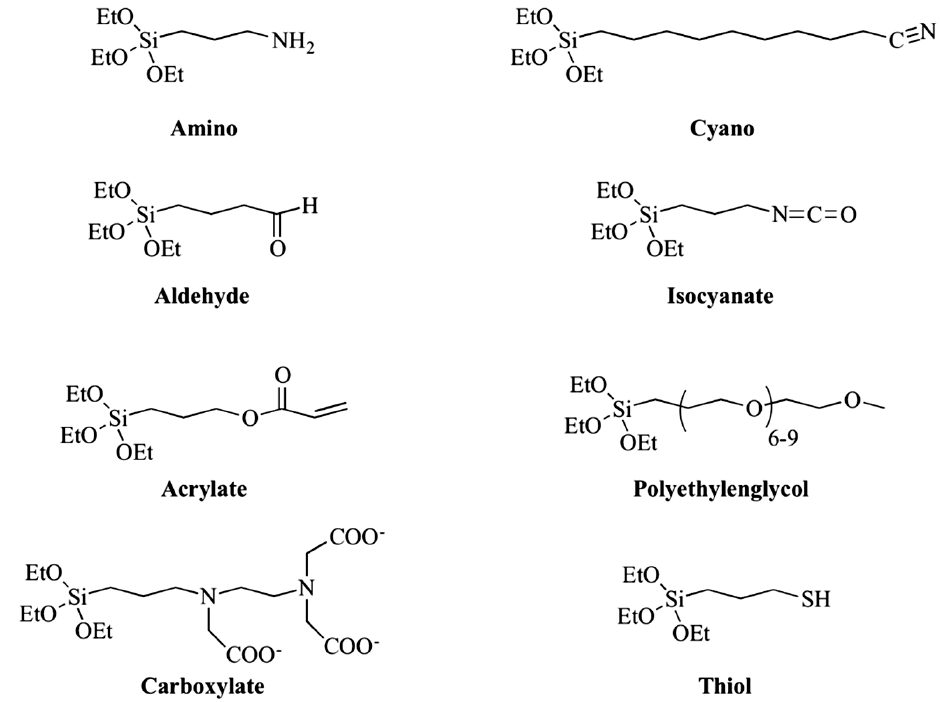
Figure 3. Structure of common silane-based molecules for the ligand exchange